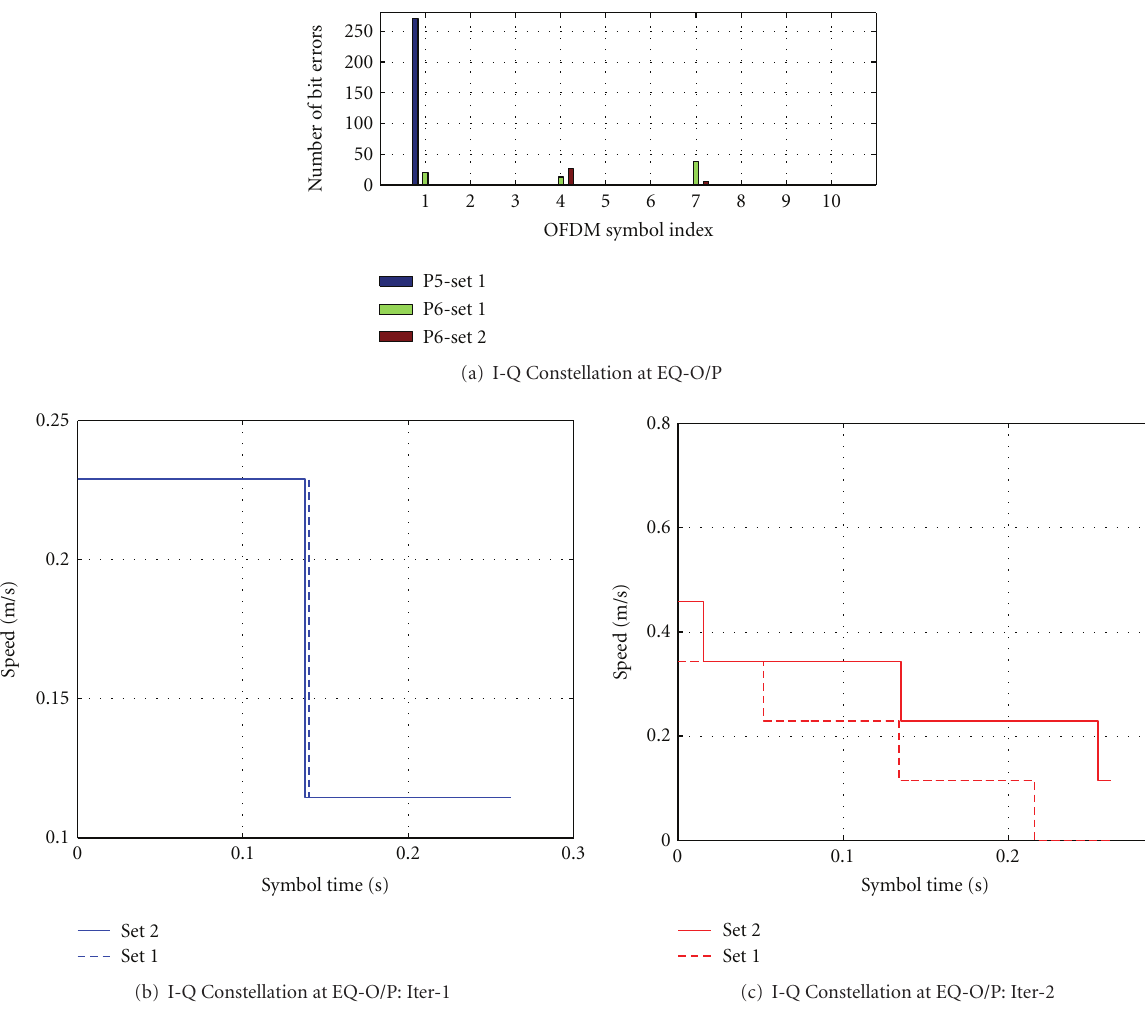
Figure 11: E ff ect of weighting coe ffi cients on